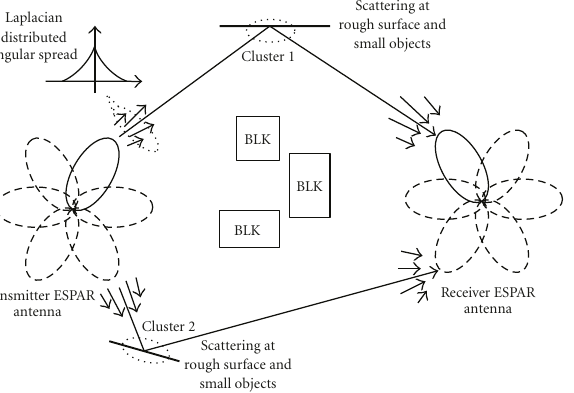
Figure 5: System model of employing directional antennas at both ends of the wireless link in a clustering DDRC.